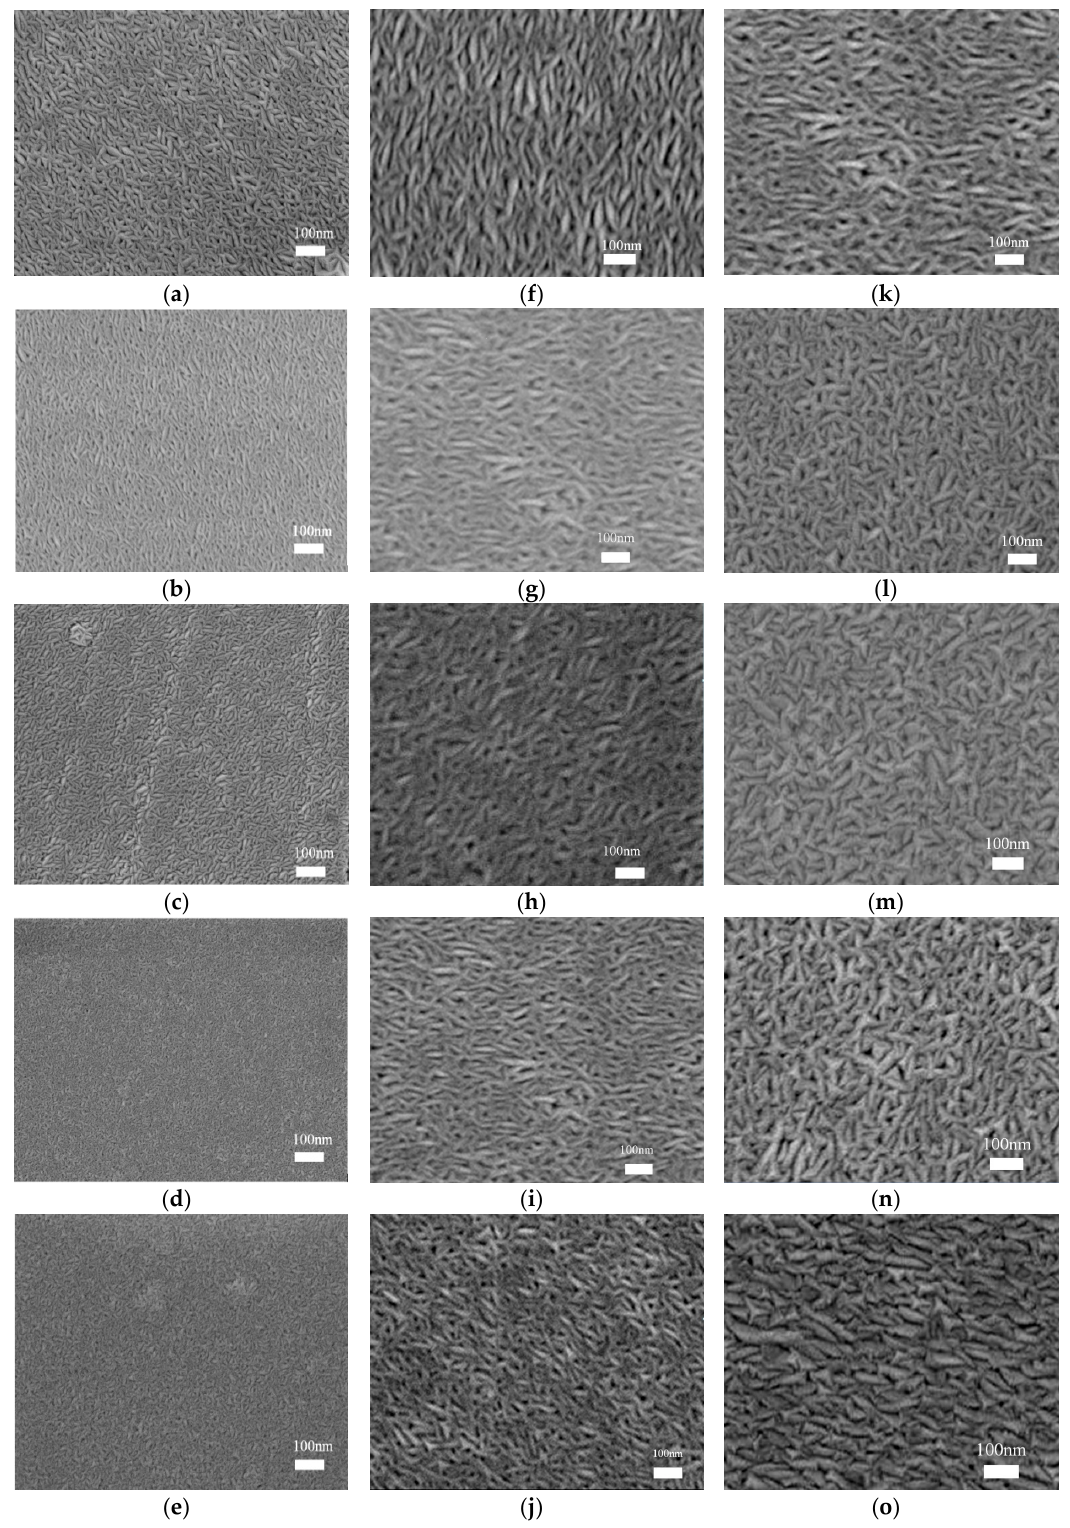
Figure 2. Scanning electron microscope (SEM) images of bottom layer Mo films deposited at different bottom layer sputtering pressures: ( a ) 0.4 Pa, ( b ) 0.6 Pa, ( c ) 0.8 Pa, ( d ) 1.0 Pa, ( e ) 1.2 Pa, Mo bilayer films deposited at different sputtering pressures: ( f ) 0.4 Pa, ( g ) 0.6 Pa, ( h ) 0.8 Pa, ( i ) 1.0 Pa, ( j ) 1.2 Pa and Mo bilayer films annealed at different temperatures: ( k ) 100 ◦ C, ( l ) 150 ◦ C, ( m ) 200 ◦ C, ( n ) 300 ◦ C, and ( o ) 400 ◦